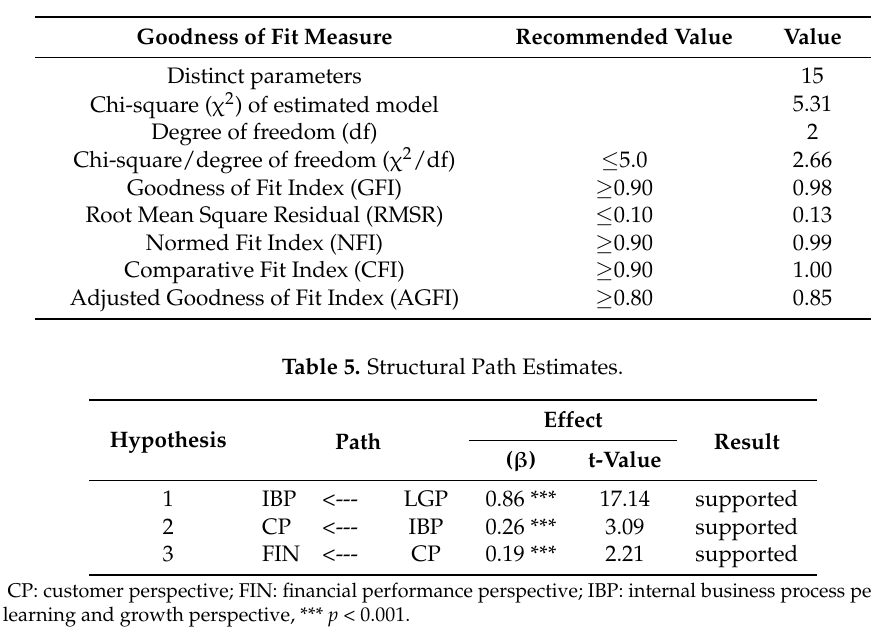
Table 4. Goodness of Fit Measure of the Proposed Model.